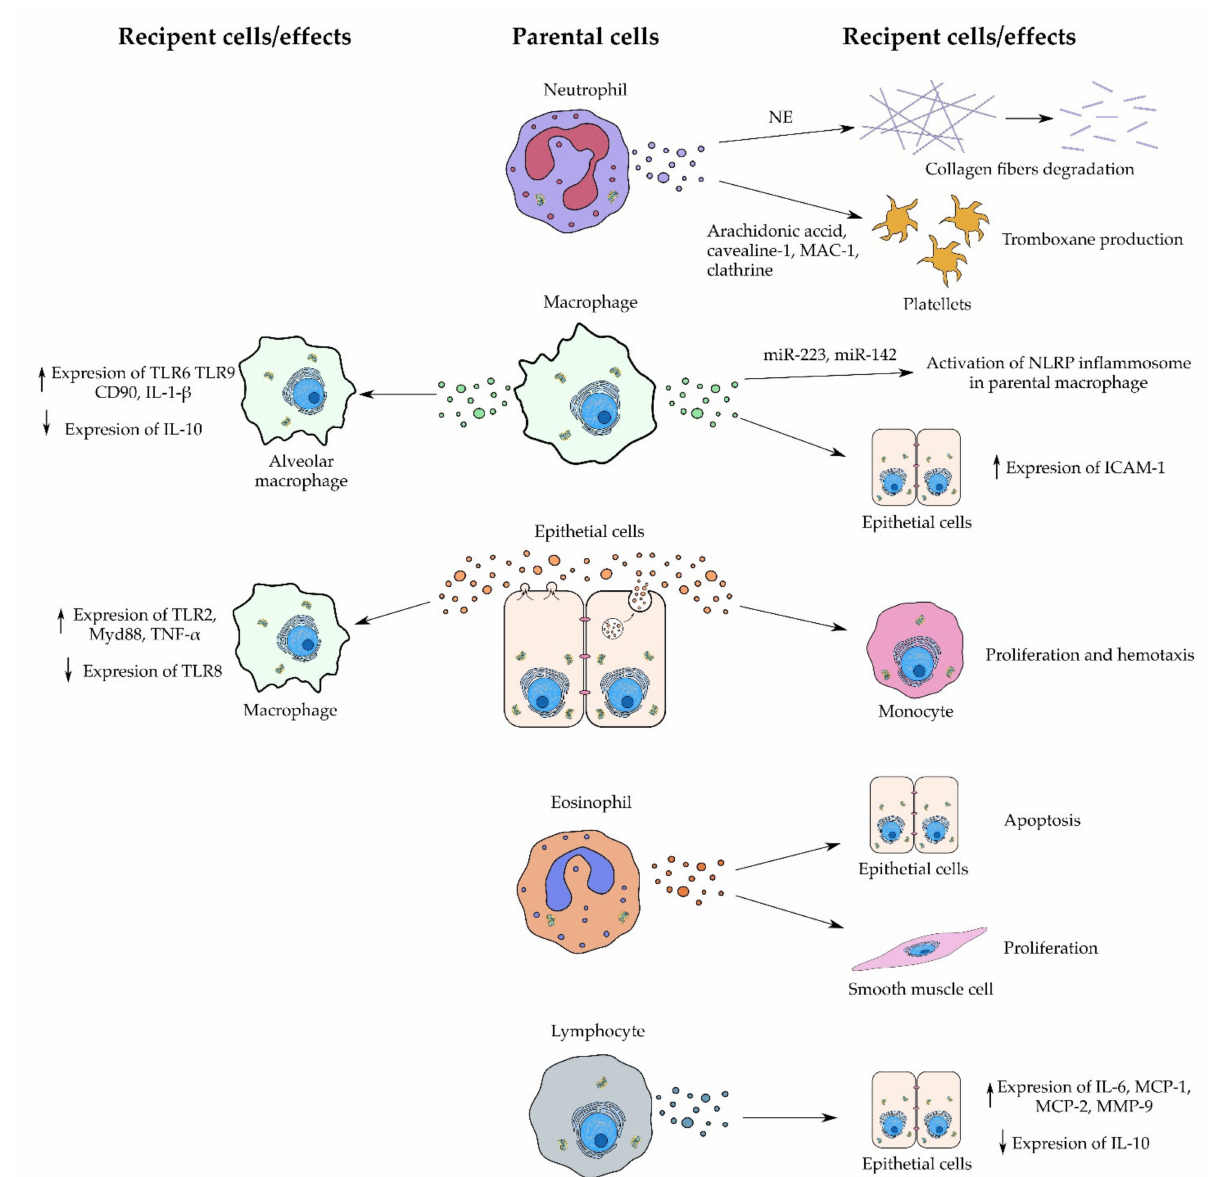
Figure 2. Action of EVs derived from various types of parental cell during the inflammation process. EVs can act indirectly by inducing parental cells and directly as shown in the case of collagen fiber